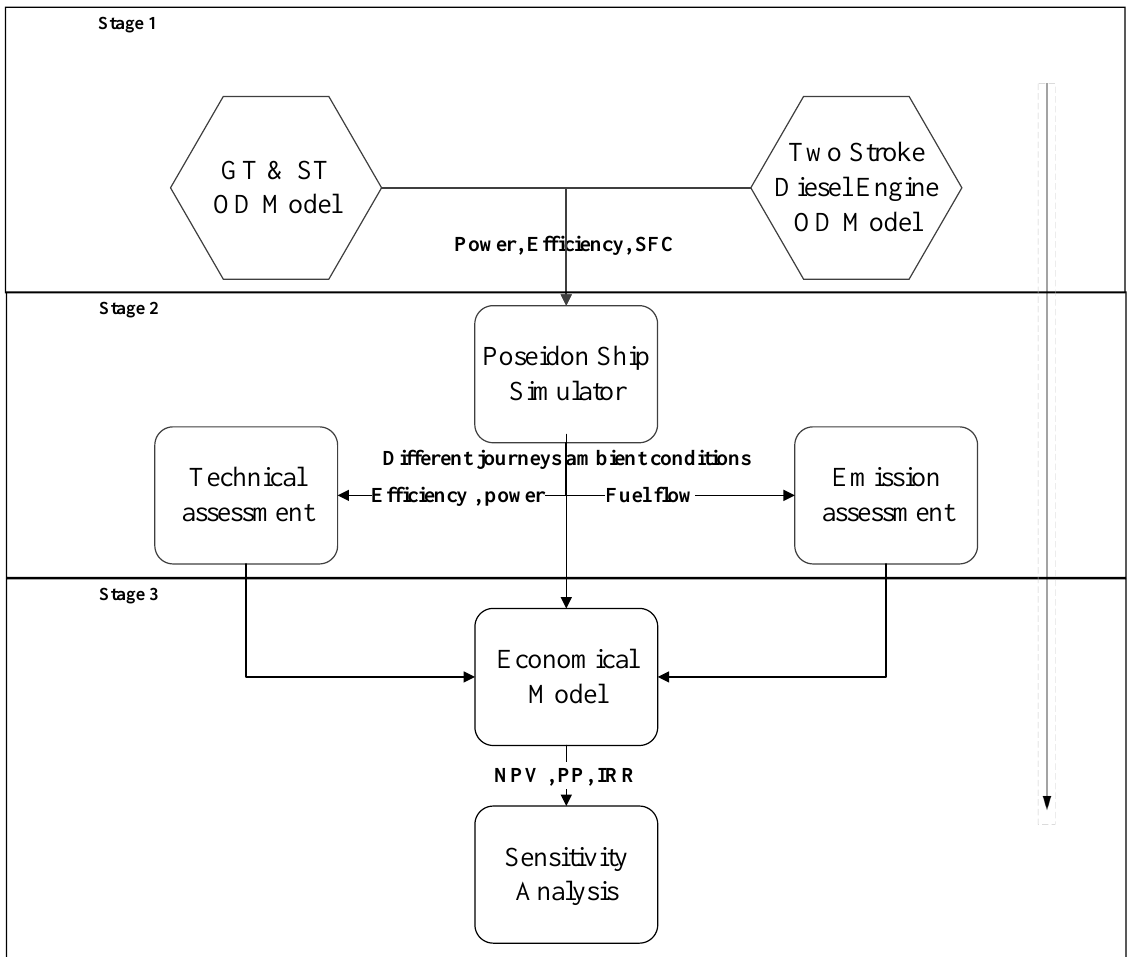
Figure 1. The framework of the methodology. GT: Gas turbine; ST: Steam turbine; OD: Off-design; NPV: Net present value; PP: Pay-back period; IRR: Internal rate of return.